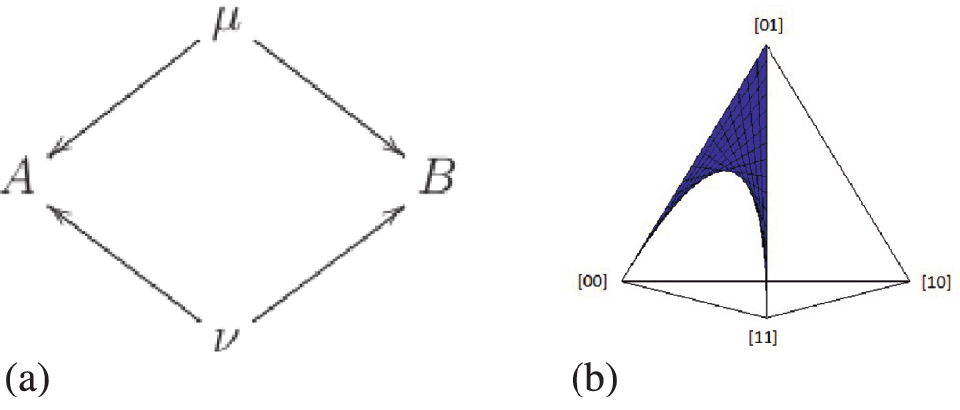
Figure 7 (a) u = uu and u = u ⊕ u ⊕ uu . (b)  u